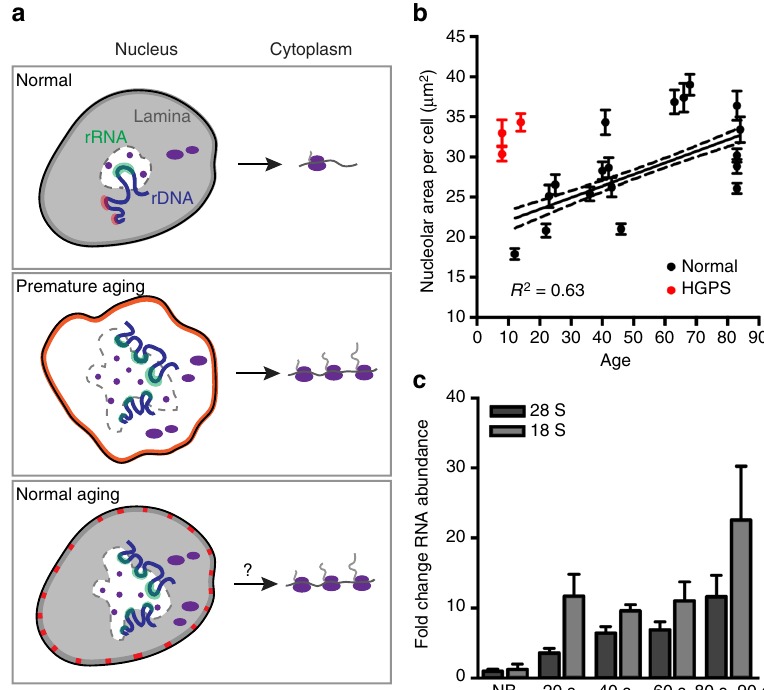
Fig. 7 Nucleolar size and rRNA production increase during normal aging. a Total nucleolar area per cell, determined by boundaries of nucleolin immuno fl uorescence, in cells from healthy individuals of varying ages ( black ) or cells from HGPS patients ( red ). Dots and bars indicate mean ± SEM for N > 34 cells per condition from 1 – 2 independent experiments with two technical replicates. Pearson correlation coef fi cient 0.6, p < 0.005. See also Supplementary Fig. 11 and Supplementary Table 4. b Abundance of 28 S and 18 S rRNAs determined by qPCR in 2 – 3 samples each from healthy individuals of varying ages. Normalized to GAPDH mRNA. NB, newborn. Bars , SEM. Representative data from 1 of 2 independent experiments shown. See also Supplementary Fig. 12 and Supplementary Table 5. c Model. In normal cells ( top panel ), the nucleoplasmic lamin network represses nucleolar activity. In HGPS ( middle panel ), the nucleoplasmic lamin network is lost. Loss of rDNA repression leads to elevated rRNA transcription, enlarged nucleoli, increased expression of ribosomal proteins, and increased translation output. In normal aging ( bottom panel ), progerin is sporadically expressed and incorporates into the lamina ( red ). Nucleoli expand, produce more rRNA, and possibly produce more translating